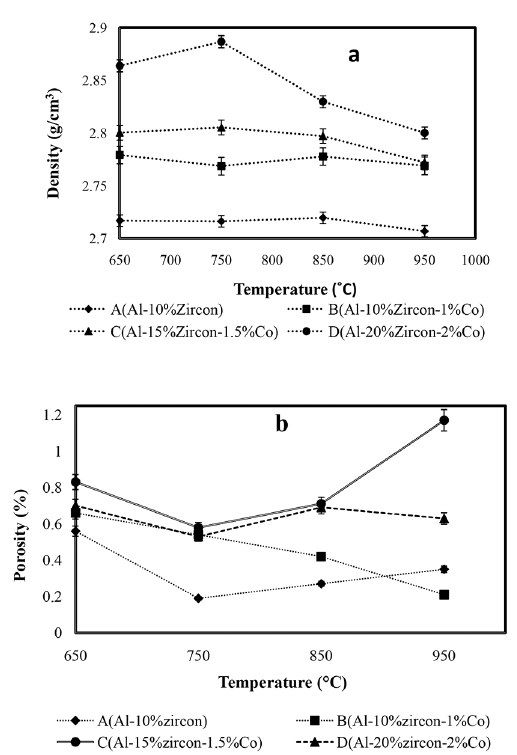
Figure 1: (a) Density and (b) porosity of Al composites sintered at temperatures 650˚, 750˚, 850˚ and 950˚C with microwave processing. microwave irradiation. The comparison between composites A and B shows the effect of cobalt additive on density.